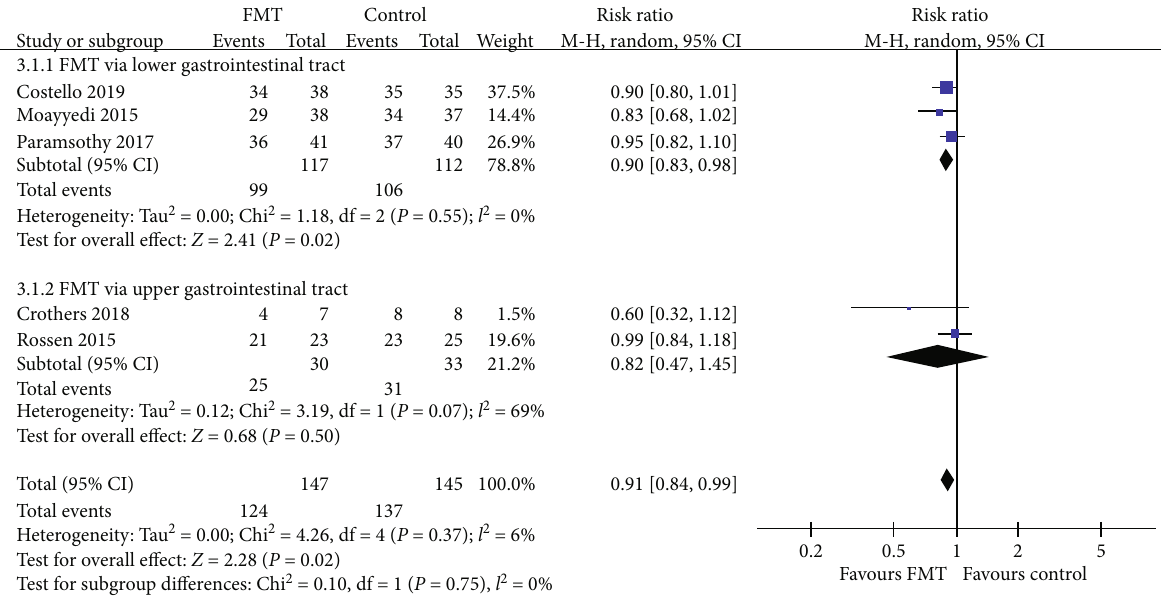
Figure 9: Forest plot of studies reporting endoscopic remission and subgroup analysis according to di ff erent delivery routes.